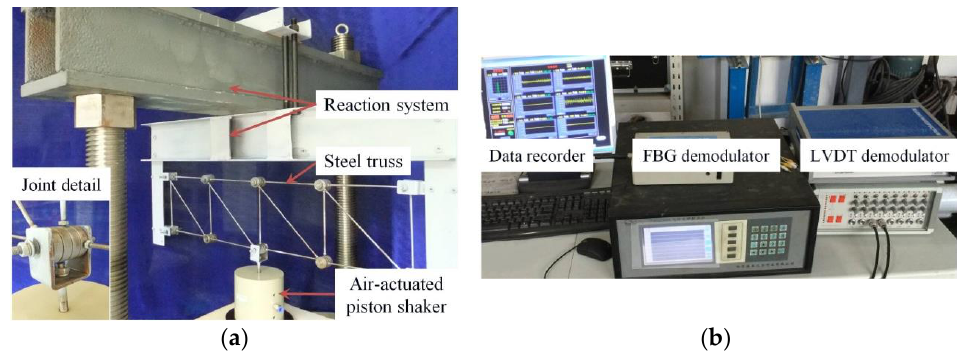
Figure 3. Experimental setup: ( a ) steel truss and loading device and ( b ) data acquisition system.